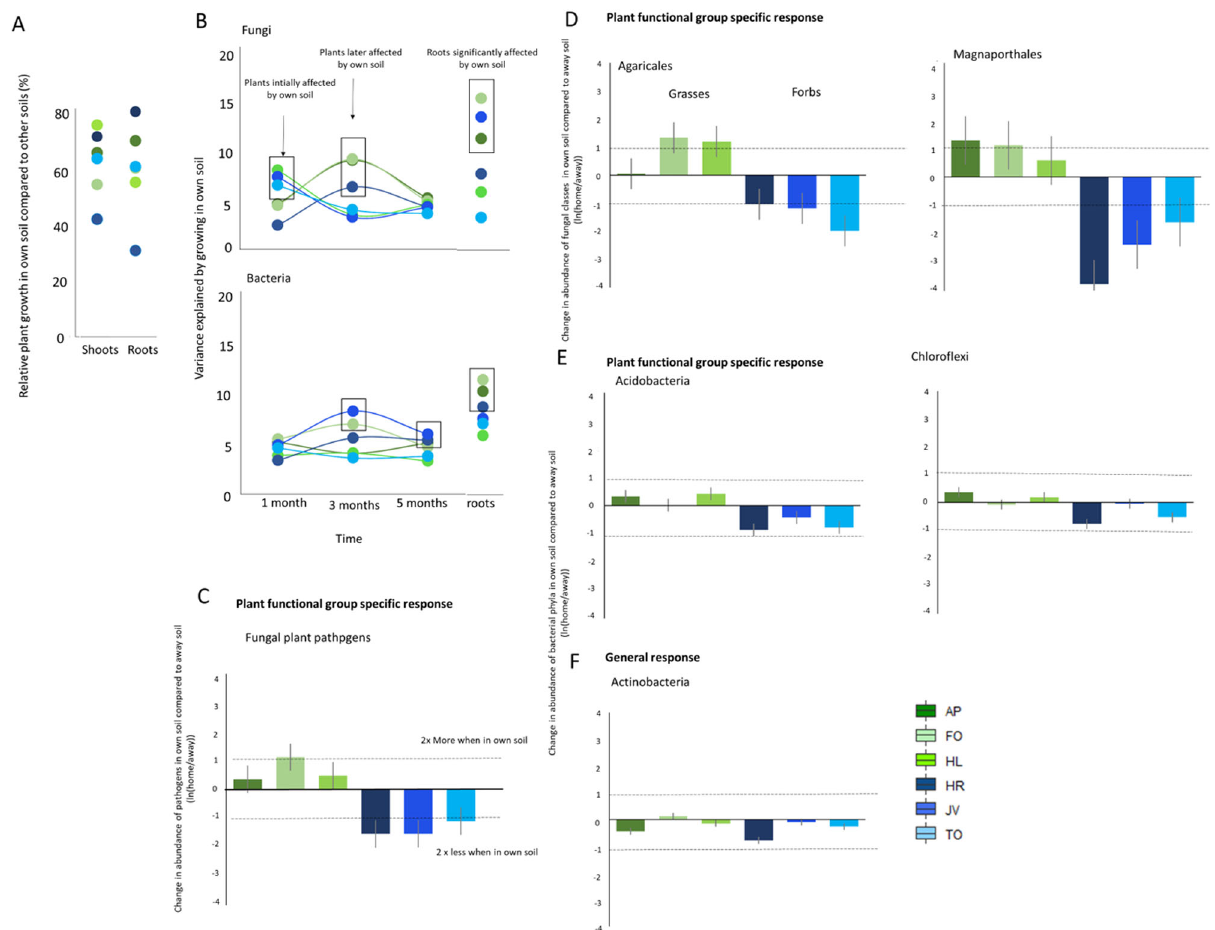
Fig. 7 Home-away effects on plants and microbial groups. Plant growth in their own vs other soils. A the relative plant growth of the plant in its own soil compared to that in other soils for shoots and roots. B the variance (measured as R 2 values) explained by growing in own soil (vs other soils) over time and between plants species estimated with PERMANOVA. Signi fi cant effects ( p < 0.05) are indicated in black boxes. C functional groups of fungi, D fungal orders, and E bacterial phyla affected signi fi cantly by plants growing in the soil where plants from same family had grown earlier calculated using a log-ratio [ln(home/away)]. F The only bacterial phyla signi fi cantly affected consistently across plant species when the plants were grown in their own soil calculated using a log-ratio [ln(home/away)]. Bars represent mean home-away effects and error-bars represent standard errors calculated based on individual replicated blocks ( n = 5). Plant species speci fi c effects of growing in their own soils on fungal classes and bacterial phyla are shown in Supplementary Fig. 12. The colors refer to plant species, green colors mark Poaceae and blue colors Asteraceae. The effect of abundance in own soil vs other soils is calculated by dividing the taxa abundance in own soil by the abundance in all other soils. Dotted lines mark when there are two times more or two times less members of fungi or bacteria in